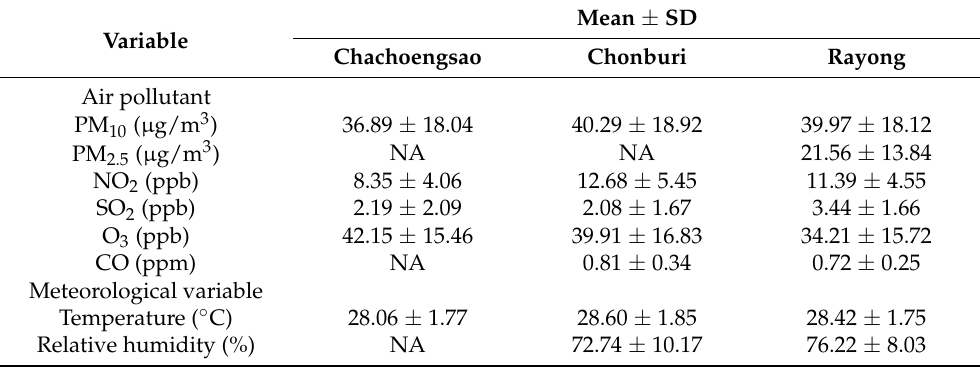
Table 1. Summary statistics for the air pollutant concentrations and meteorological variables for the three provinces in the Eastern Economic Corridor of Thailand between 2013 and